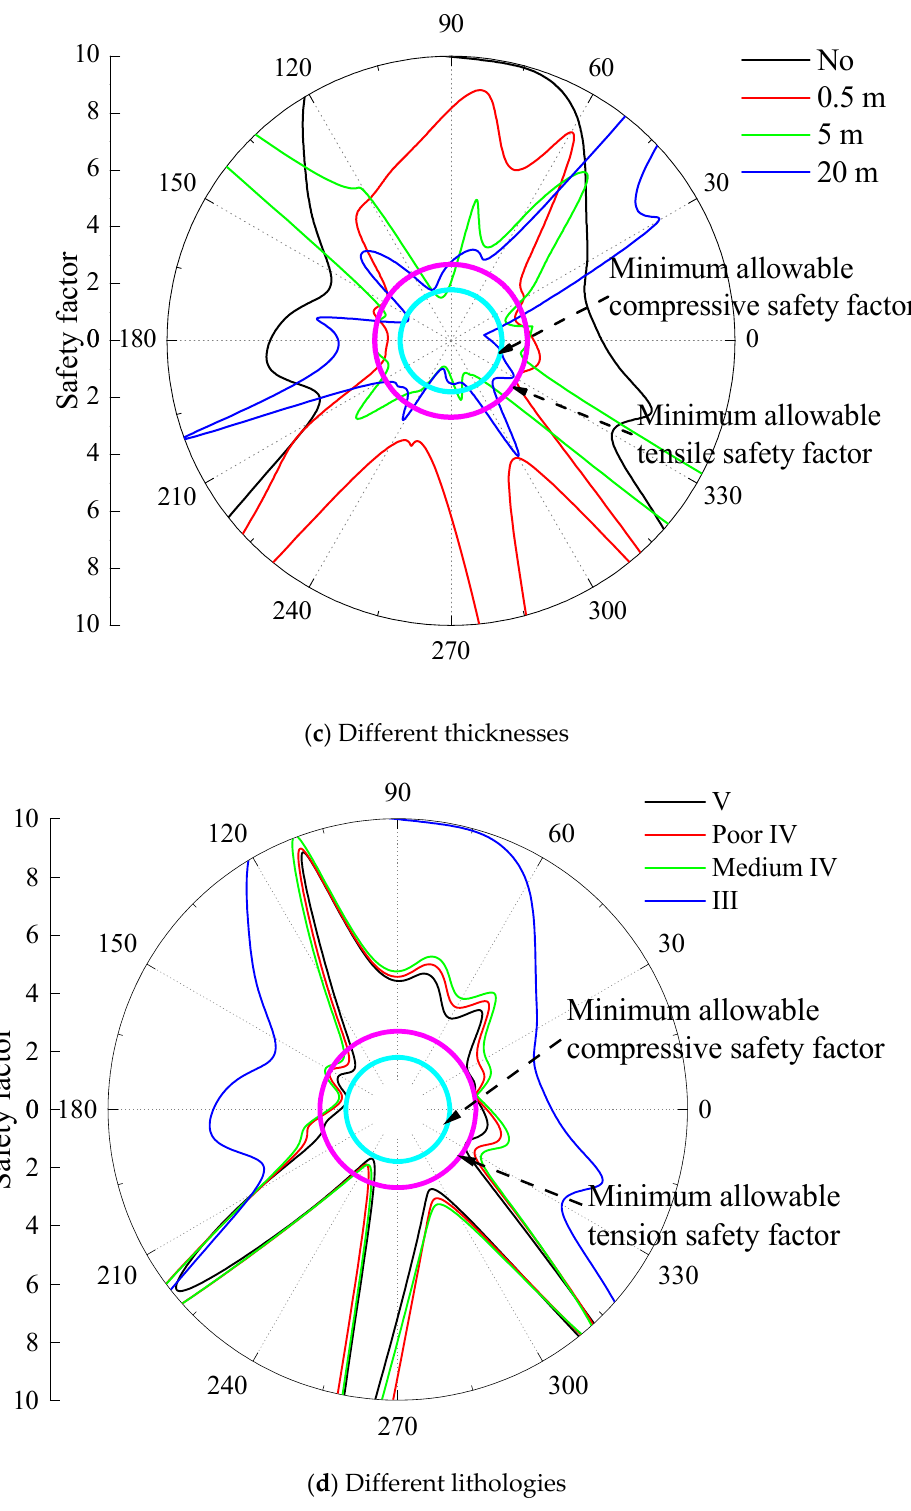
Figure 15. Safety factor distribution of cross section at y = 500 m.